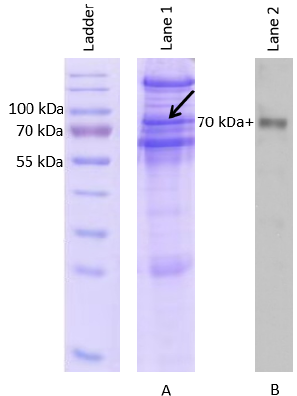
Figure 1. SDS ‐ PAGE analysis of isolated Chinese soft ‐ shelled turtle immunoglobulin ( A ) followed by Figure 1. SDS-PAGE analysis of isolated Chinese soft-shelled turtle immunoglobulin ( A ) followed by Western blot ( B ) using anti ‐ turtle IgM antibody raised in rabbit. The expected molecular weight of Western blot ( B ) using anti-turtle IgM antibody raised in rabbit. The expected molecular weight of soft ‐ shelled turtle IgM heavy chain is 70 kDa plus as indicated by the arrow in the figure. soft-shelled turtle IgM heavy chain is 70 kDa plus as indicated by the arrow in the Table 1. Mass spectrometry results of protein bands ≥ 70 kDa excised from the gel electrophoresis. Hits Protein Name Abbr GeneBank Acc. no.